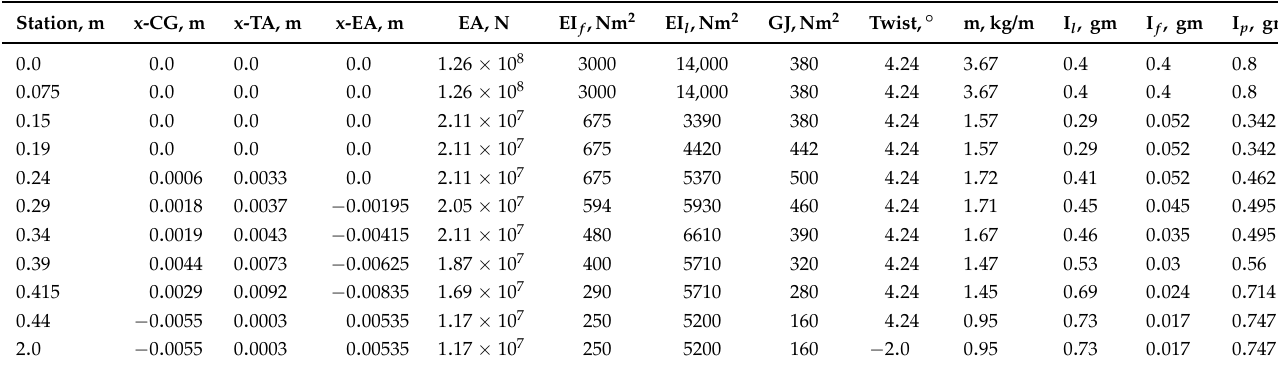
Figure 14. Tip displacement of an uncoupled flexible blade under excitation f = 10sin ( 50 t ) at the tip. Table 3. HART II blade